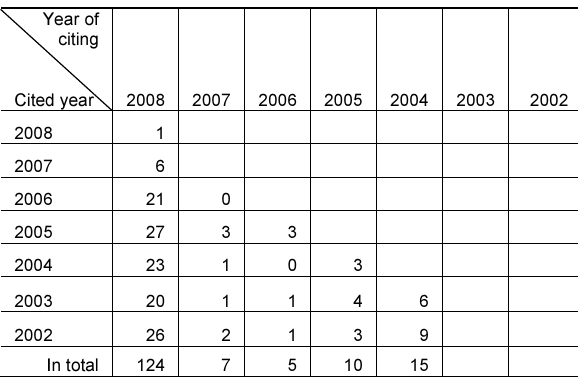
Fig. 2. Annual number of cited papers